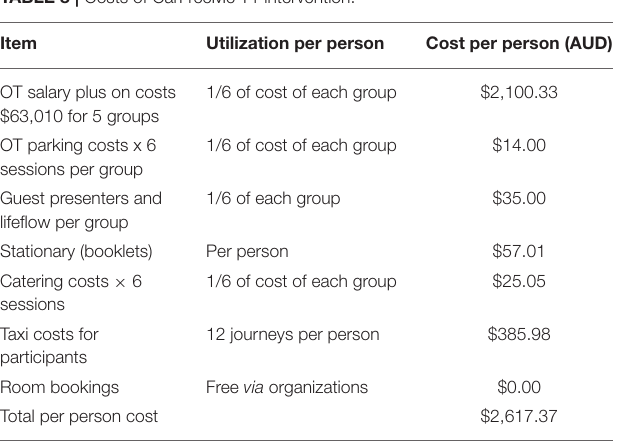
TABLE 8 | Costs of CarFreeMe T1